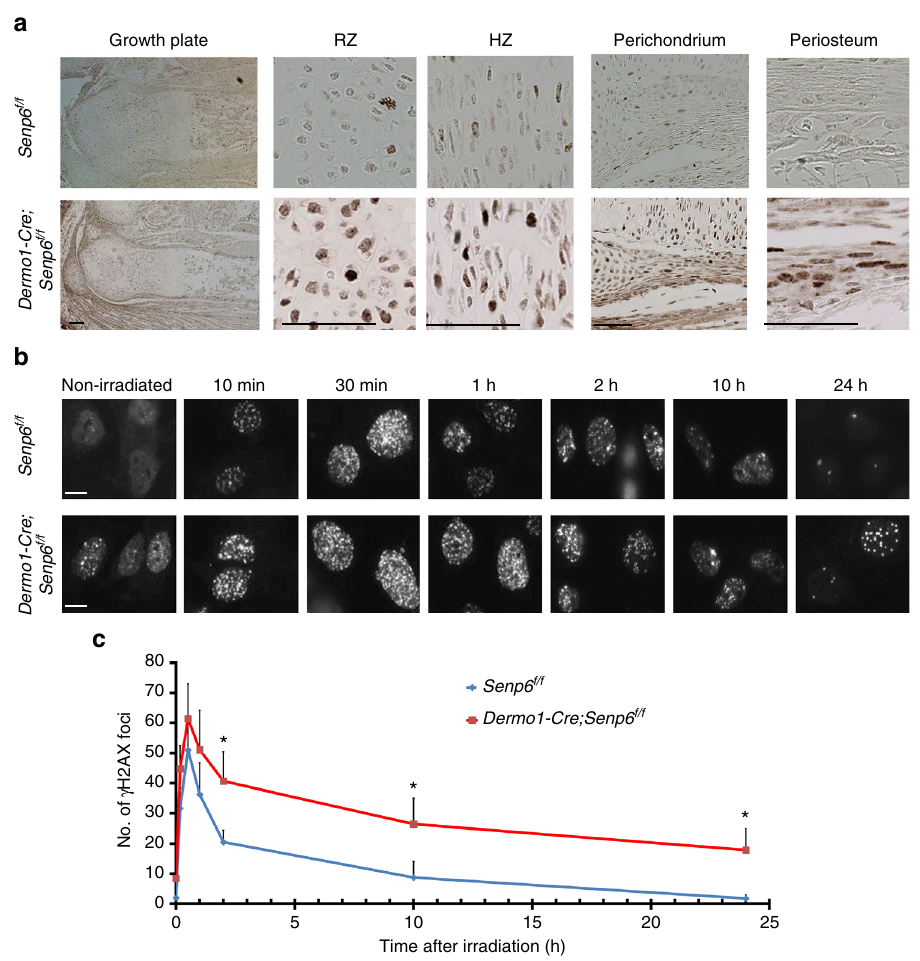
Fig. 3 Senp6 loss delayed DNA damage repair. a Dermo1-Cre;Senp6 f/f mice (E18.5) had more γ H2AX-positive cells in the growth plate RZ, PZ, perichondrium, and periosteum than did Senp6 f/f controls; scale bars = 100 μ m for the growth plate (left) and 50 μ m for the rest. b Dermo1-Cre;Senp6 f/f mice showed an increased basal level of γ H2AX foci (non-irradiated), higher sensitivity to irradiation (at 10 min), and lower clearance of γ H2AX foci during recovery at 30 min to 24 h ( n = 3; 50 areas of each slide were quanti fi ed, error bars = standard deviation, * p < 0.05, relative to control, Student ’ s t -test); scale bars = 10 μ and apoptosis, we compared the gene expression pro fi les of cul- tured rib chondrocytes from Dermo1-Cre;Senp6 f/f and Senp6 f/f (control) mice by RNA sequencing (RNA-seq). The DAVID Gene